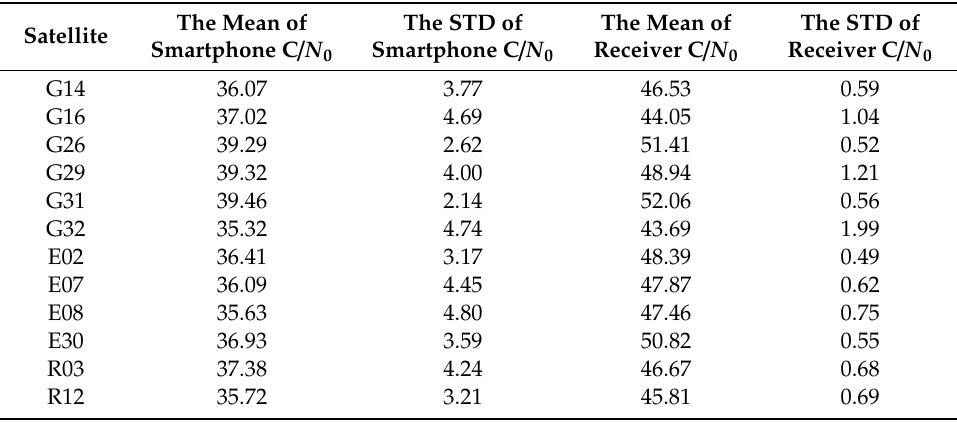
Table 6. Mean and standard deviation of C/ N 0 of GPS, Galileo and GLONASS [dB-Hz].